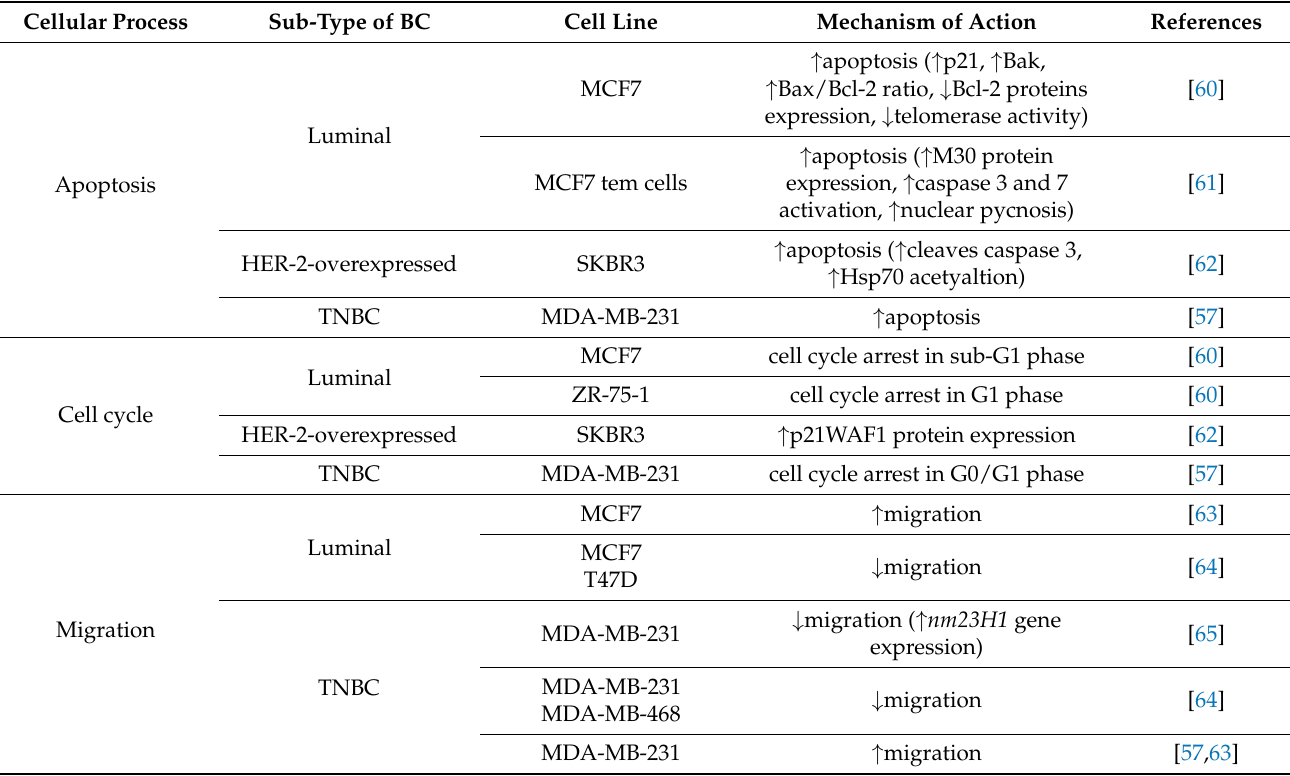
Table 3. Mechanism of action of valproic acid (VPA) in in vitro breast cancer (BC) pre-clinical setting (BC-breast cancer, EMT-epithelial-mesenchymal transition, ER-estrogen receptor, HER-2-human epidermal growth factor receptor 2). Cellular